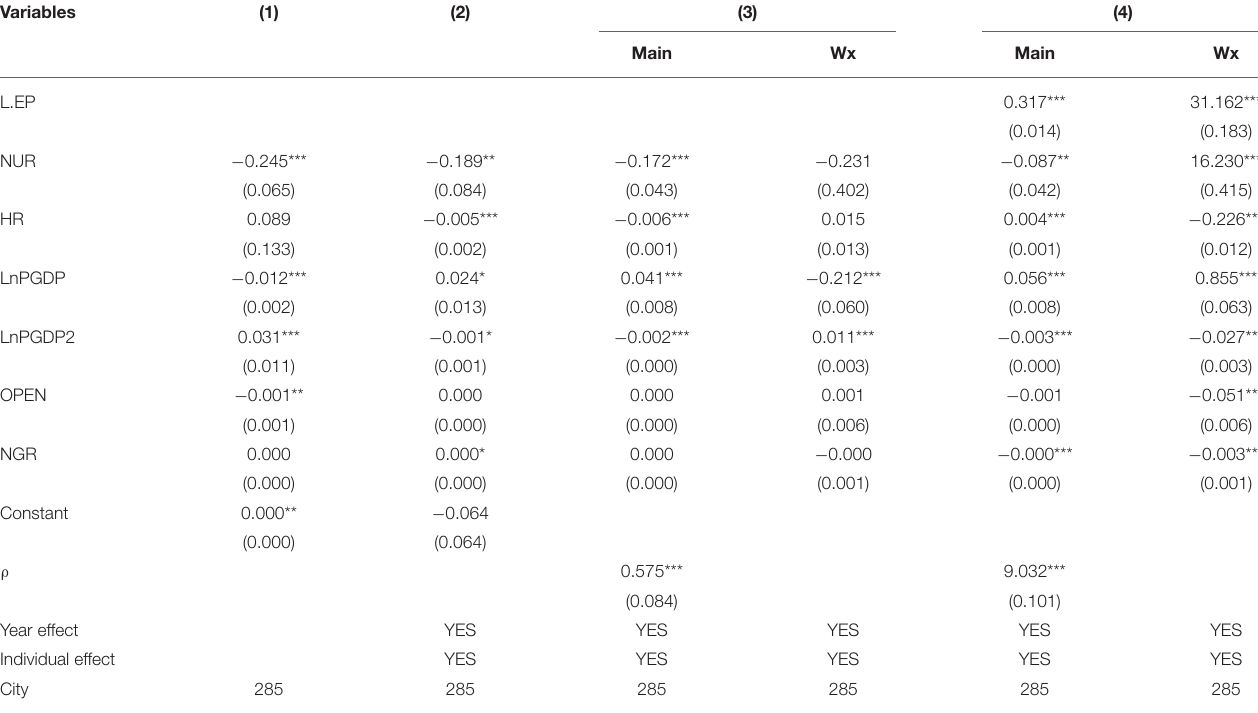
TABLE 5 | Baseline regression